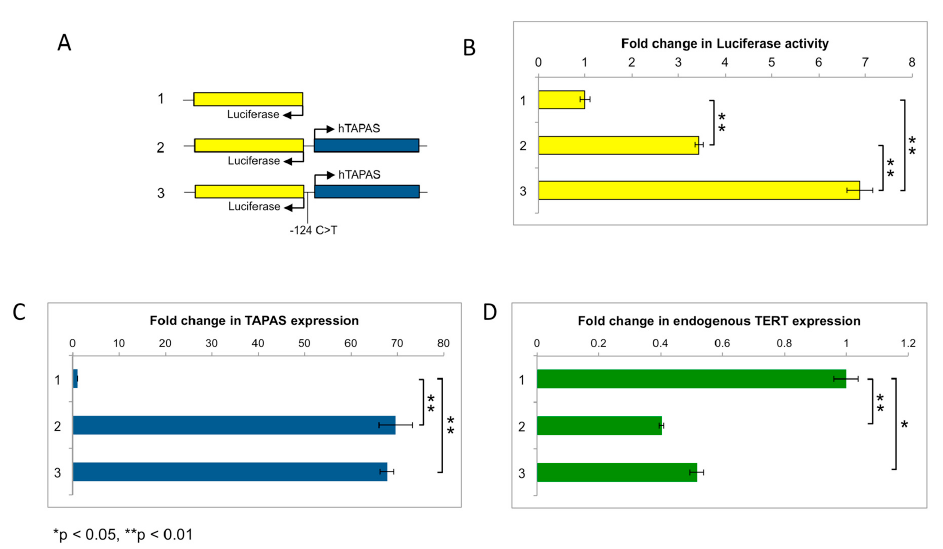
Figure 5. Presence of the hTERT promoter mutation does not alter hTAPAS expression. ( A ) Schematic representation of an empty control vector (1), and hTAPAS insert with a wild ‐ type (2) or mutant (3) hTERT promoter region, in a luciferase reporter vector. ( B ) Fold ‐ change in luciferase activity observed for the different constructs relative to empty vector. ( C ) Fold ‐ change in hTAPAS or ( D ) endogenous hTERT expression levels observed for the different constructs relative to empty vector.